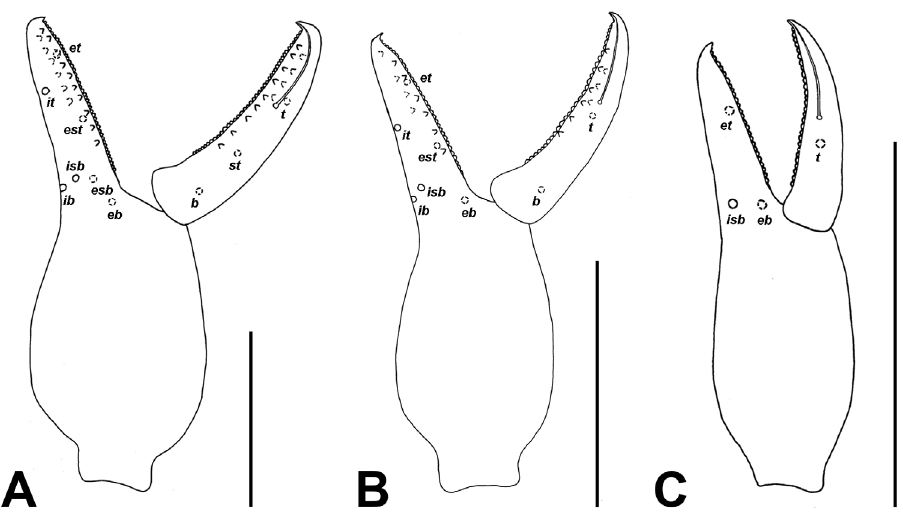
Figure 5. Palpal chela of Lasiochernes pilosus nymphs, showing the trichobothrial pattern. A Tritonymph B Deutonymph C Protonymph. Abbreviations as for Figure 4. Scale lines: 0.5